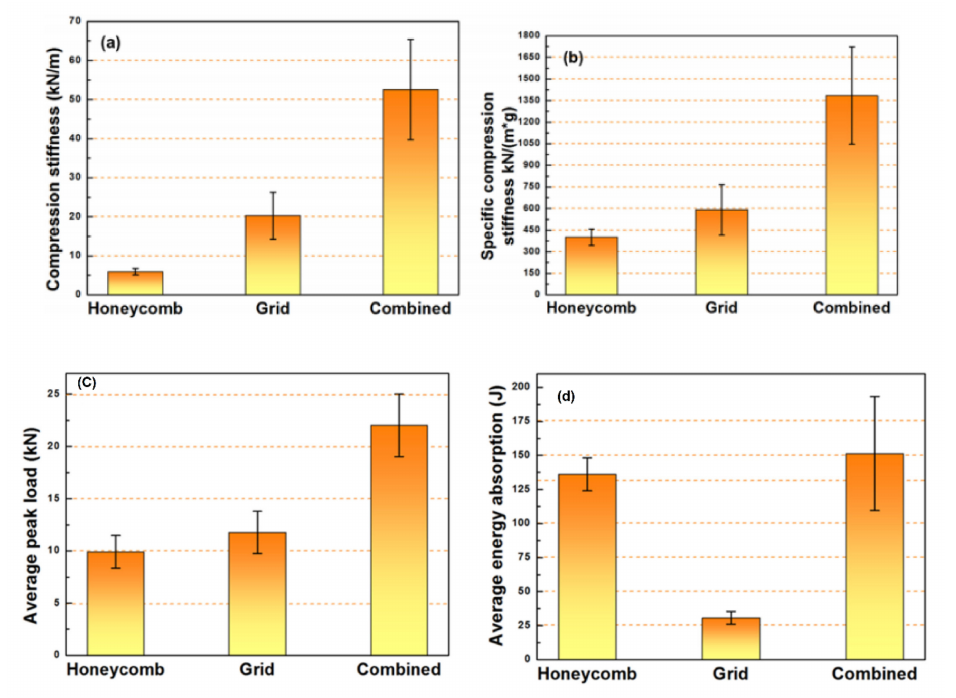
Figure 4. Average properties of sandwich specimens: ( a ) compression stiffness, ( b ) specific compression stiffness, ( c ) peak load, and ( d ) energy absorption [82].